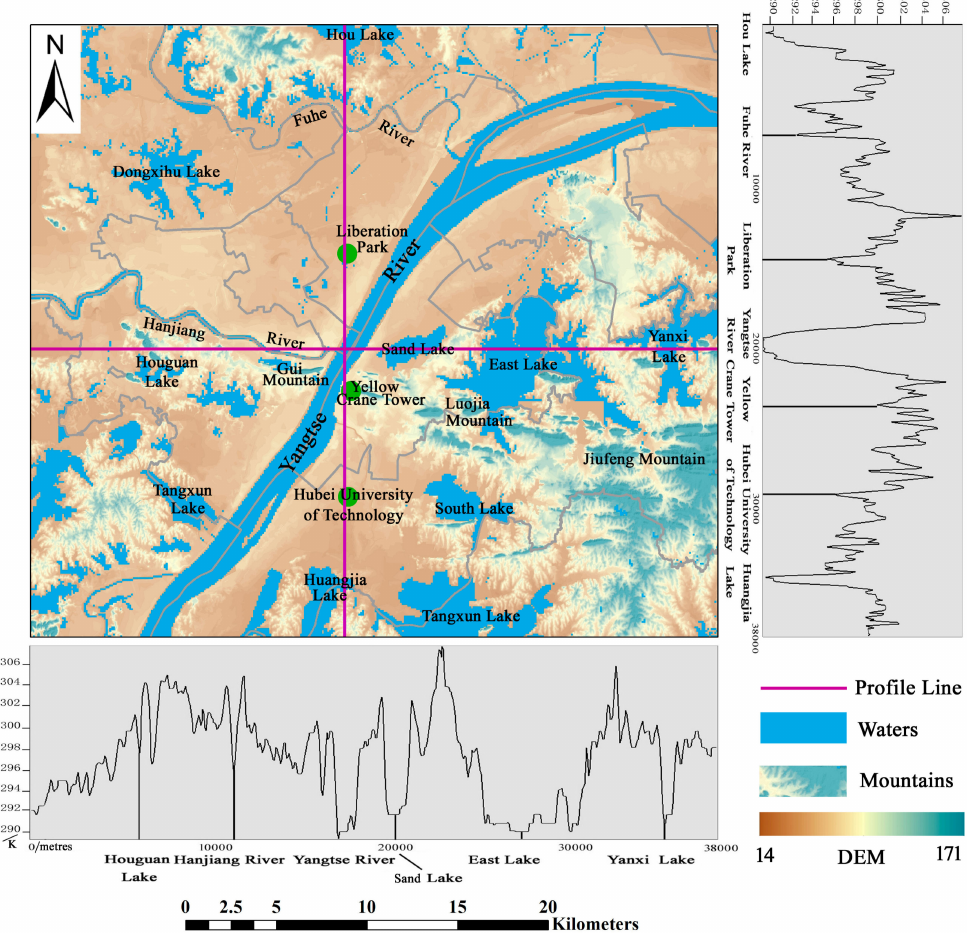
Figure 5. Land surface temperature changes in the profile